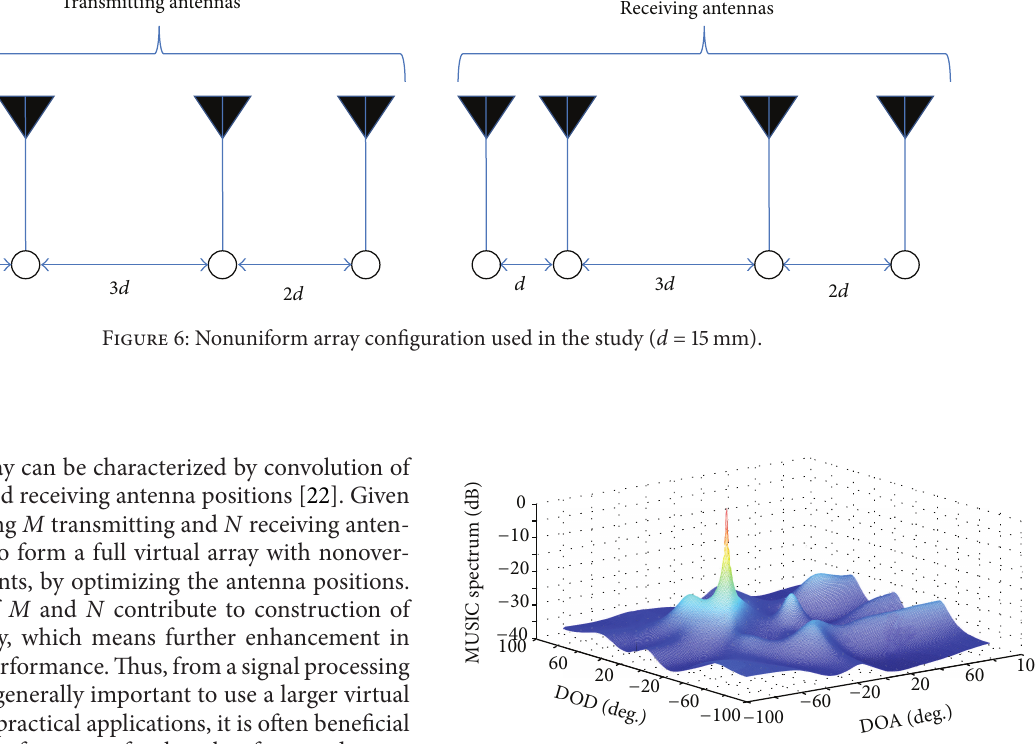
Figure 7: Example of a MUSIC spectrum using the nonuniform array configuration ( 𝑓 𝑘 = 5.0 GHz).